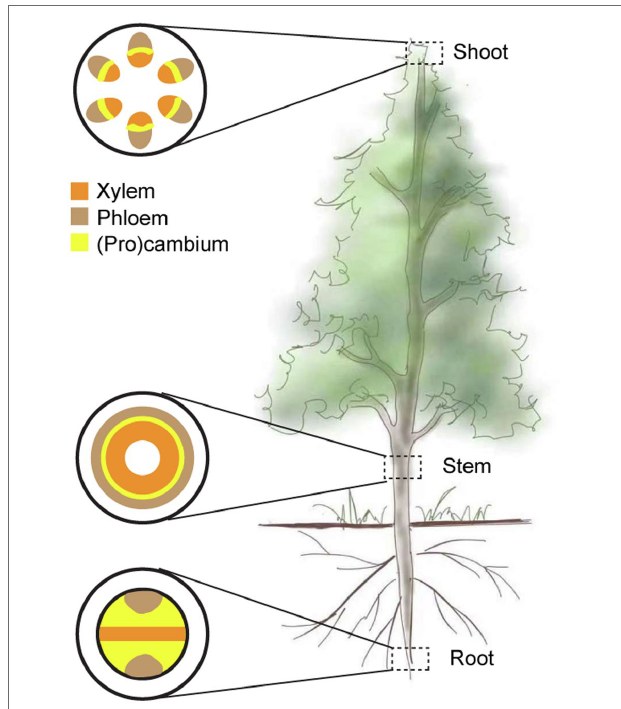
FIGURE 1 | A schematic view of vascular tissue organization in shoot, stem, and root of vascular plants. Xylem and phloem tissues are initiated from procambium in vascular plants. Shoot apical meristems and root apical meristems are two primary meristems, and vascular cambium is a cylindrical secondary meristem in stems. The xylem is represented in orange, the phloem in brown, and the cambium in